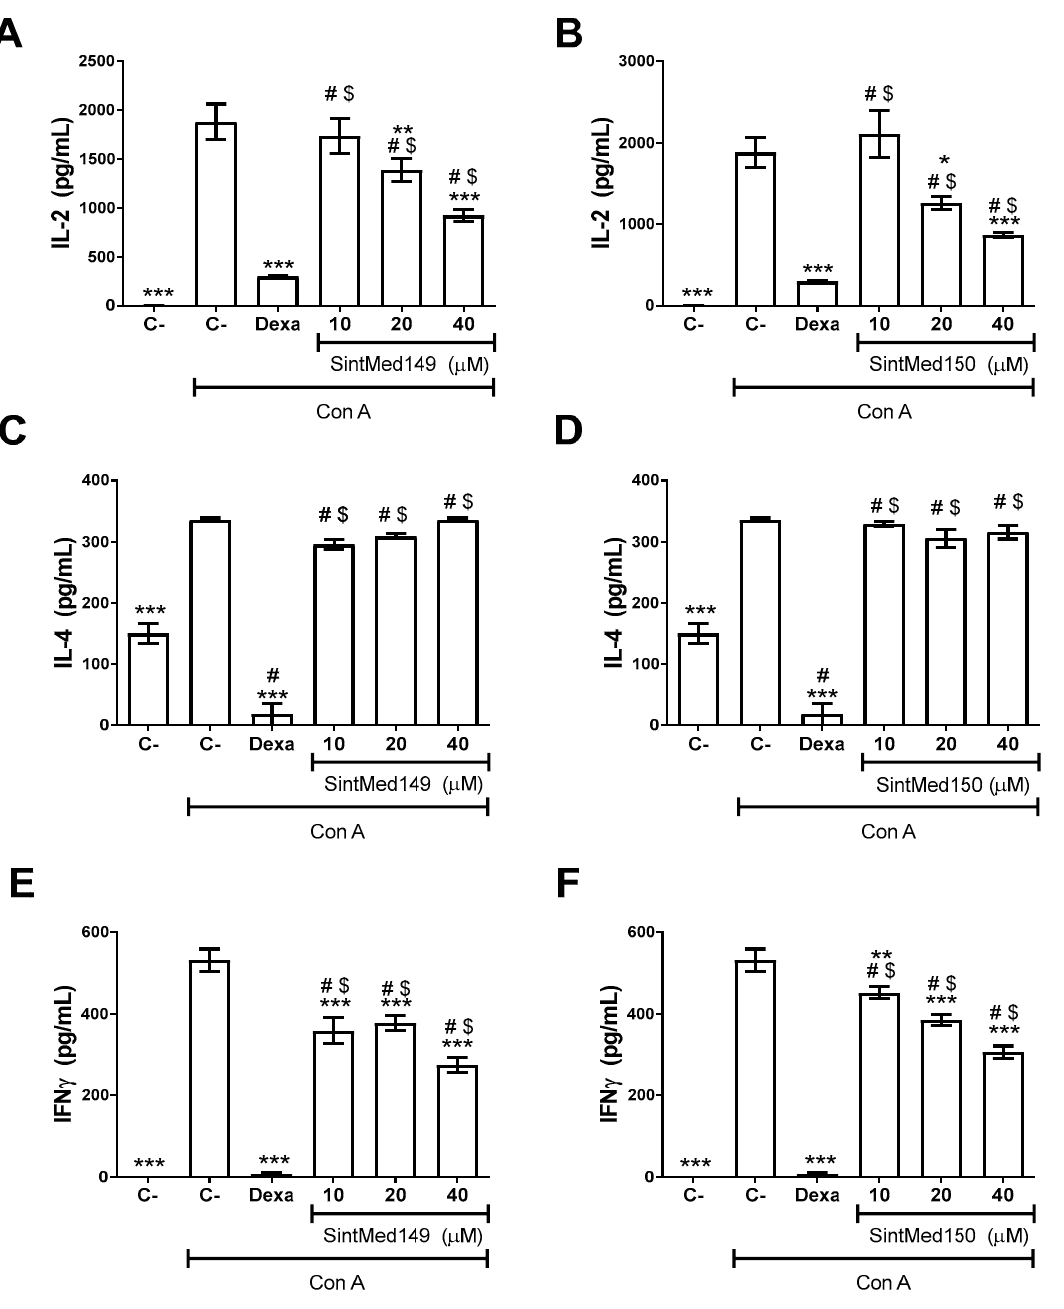
Figure 6. Assessment of cytokine production by splenocytes treated with SintMed149 and SintMed150 . The concentrations of IL-2 ( A , B ), IL-4 ( C , D ), and IFN- γ ( E , F ) were determined in cell-free supernatants from splenocyte cultures stimulated with concanavalin A (Con A, 5 µ g/mL) and treated or not with SintMed149 and SintMed150 (10, 20, 40 µ M) or dexamethasone (10 µ M) for 24 h. Culture supernatants were collected and cytokine quantification was performed by ELISA. Values represent the mean ( ± standard deviation) of four determinations obtained in one of three experiments performed. *** p < 0.001 compared to untreated and Con A-stimulated cultures ** p < 0.01 in comparison to untreated and Con A-stimulated cultures * p < 0.05 compared to untreated and Con A-stimulated cultures. # p < 0.05 compared to untreated and unstimulated cultures with Con A. $ p < 0.05 compared to dexamethasone-treated and stimulated cultures.